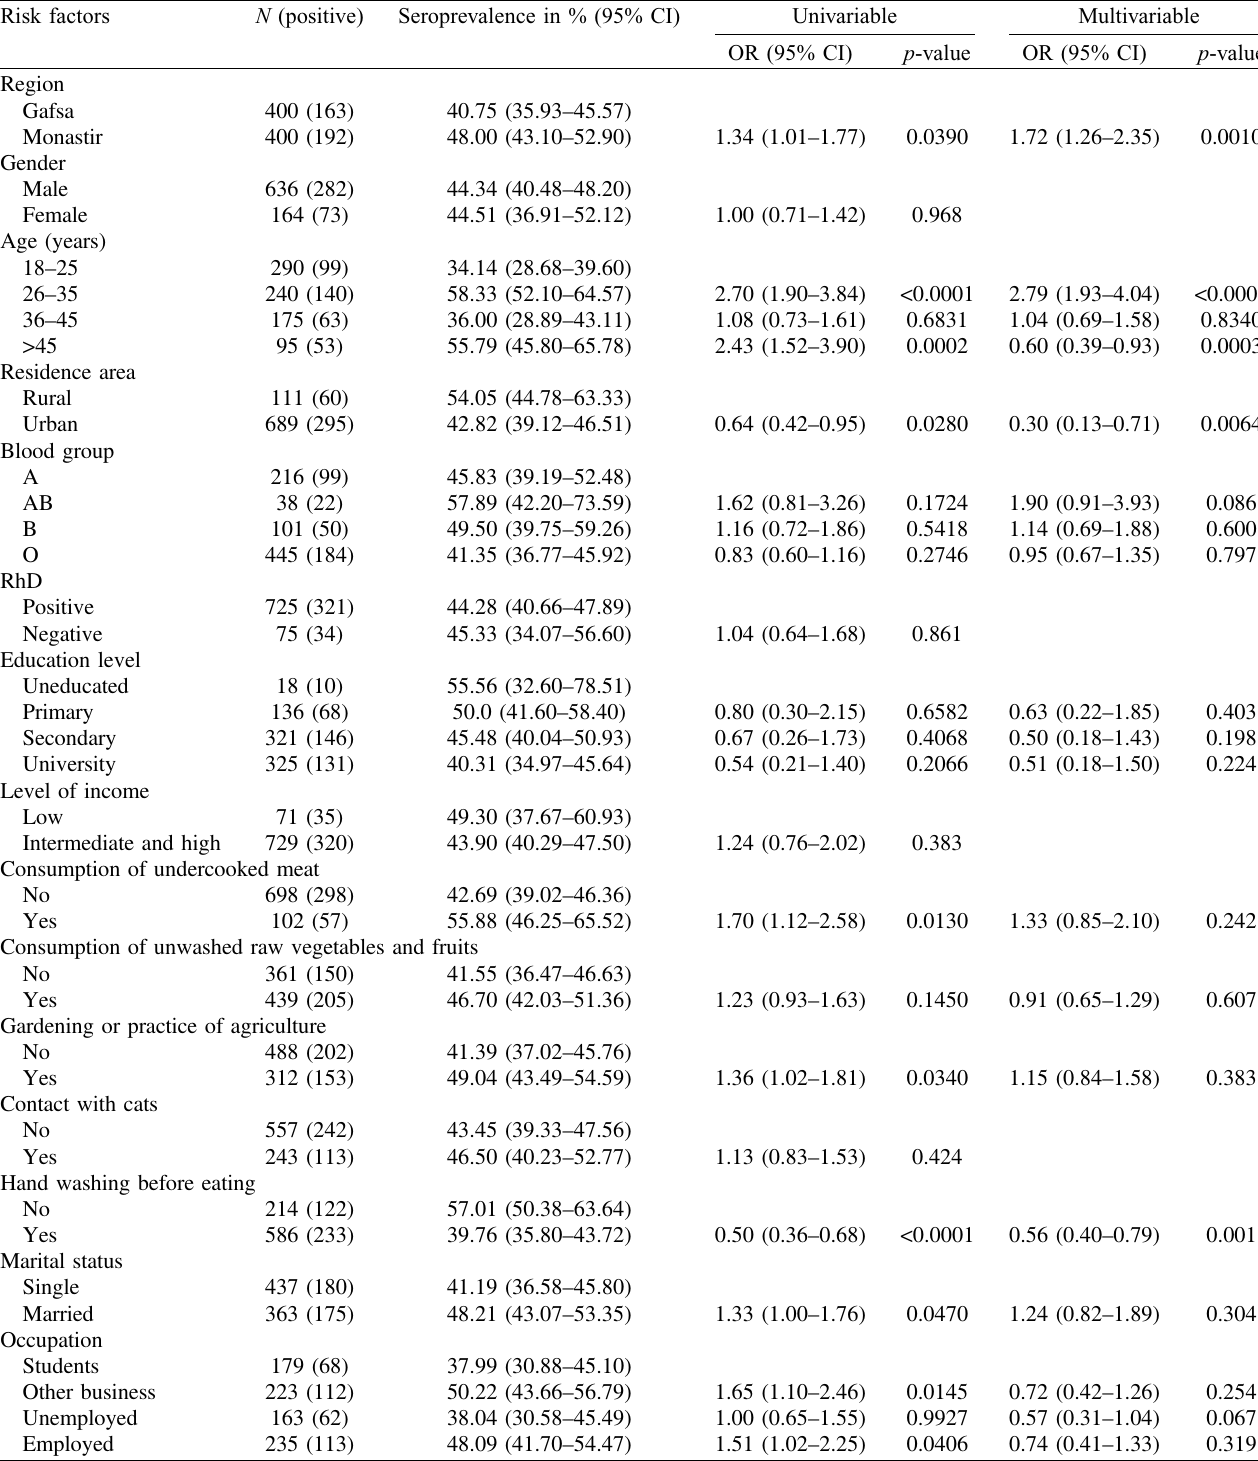
Table 1. Results of univariate and multivariate logistic regression analyses of Toxoplasma gondii seropositivity of blood donors in